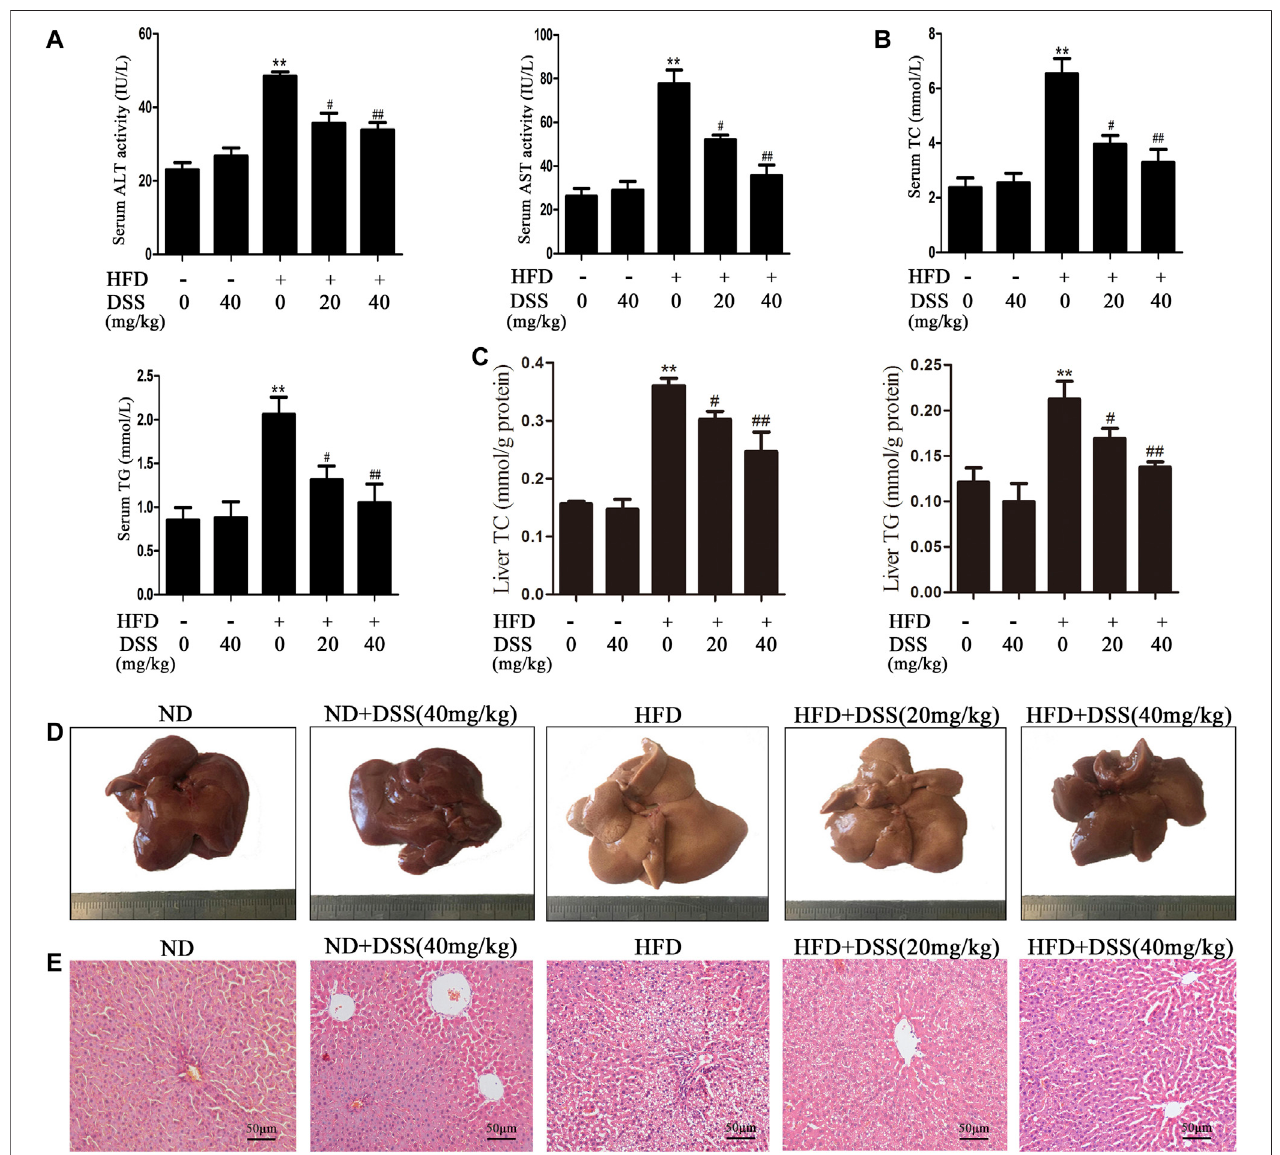
FIGURE 1| DSS alleviatesHFD-induced NAFLD in vivo . Rats were fed either a ND (control) or a HFD and treated with or without DSS. (A) Serum levels of ALT and AST ( n (cid:2) 6). (B) Serum levels of TC and TG ( n (cid:2) 8). (C) Liver levels of TC and TG ( n (cid:2) 8). ** p < 0.01 vs. the ND group; # p < 0.05, ## p < 0.01 vs. the HFD group. (D,E) Representative morphological and H&E-stained images of liver sections from the following experimental groups: the ND, DSS (40 mg/kg), HFD, HFD + DSS (20 mg/kg) and HFD + DSS (40 mg/kg) groups. H&E-stained sections were photographed at 400 × magni fi cation.